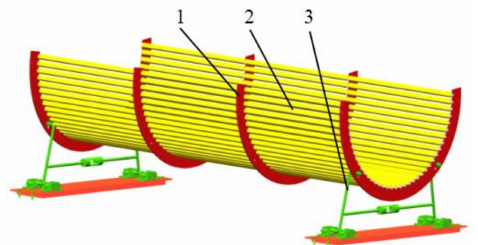
Figure 5. Structural diagram of micro rotating circular tubular concave screen: 1. side arc plate; 2. hollow circular tube rotary screening unit; 3. concave screen support